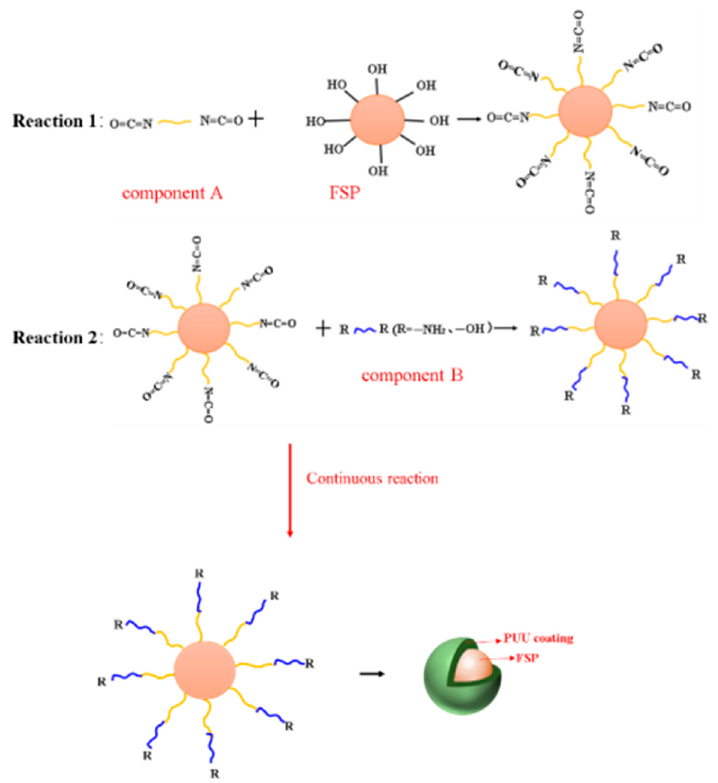
Figure 2. Component B and FSP reaction system ( a ); Component A, B and FSP reaction system ( b ).